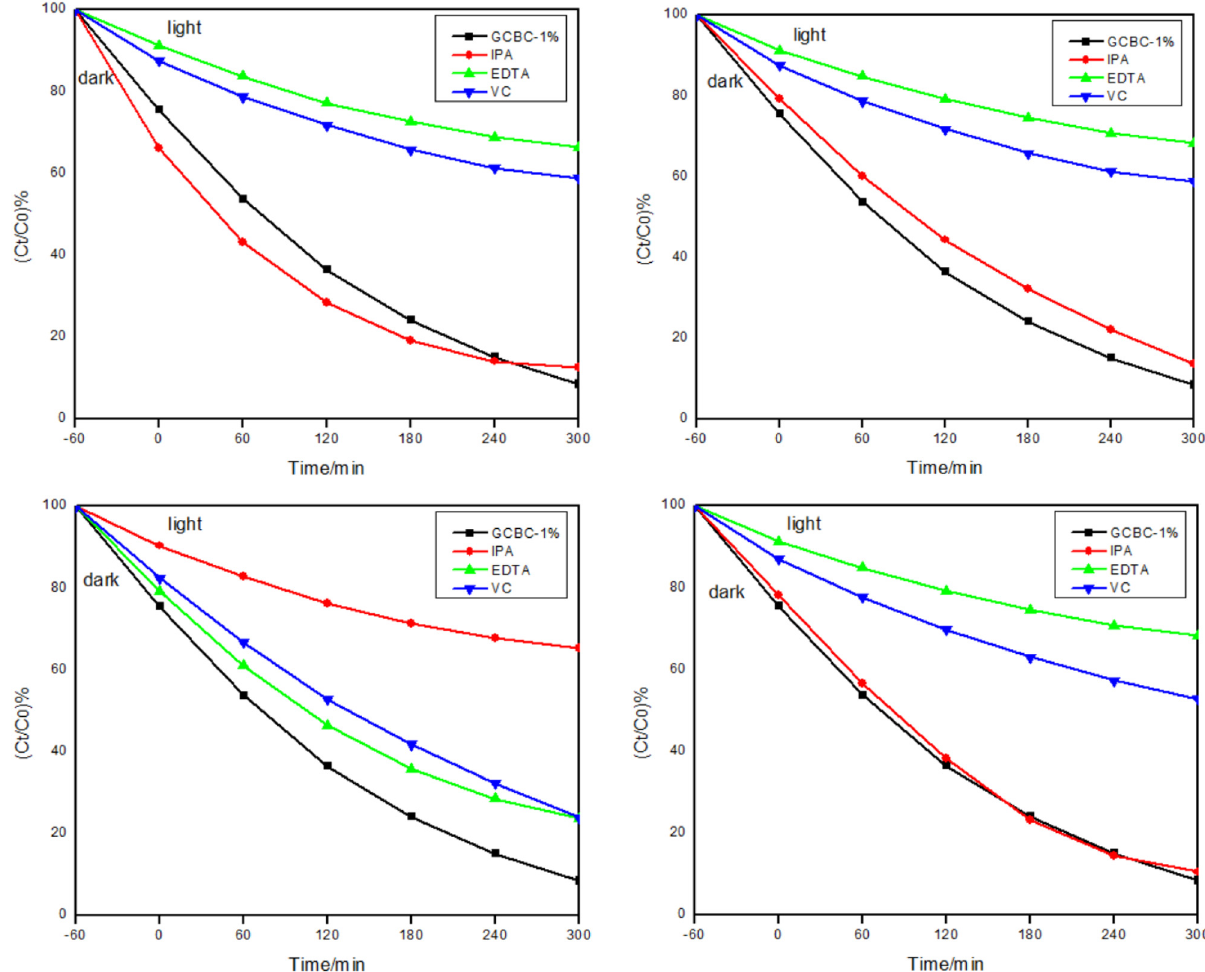
Figure 7: E ff ects of GCBC - 0.1%, M100, M271, and M285 on the photocatalytic activity of